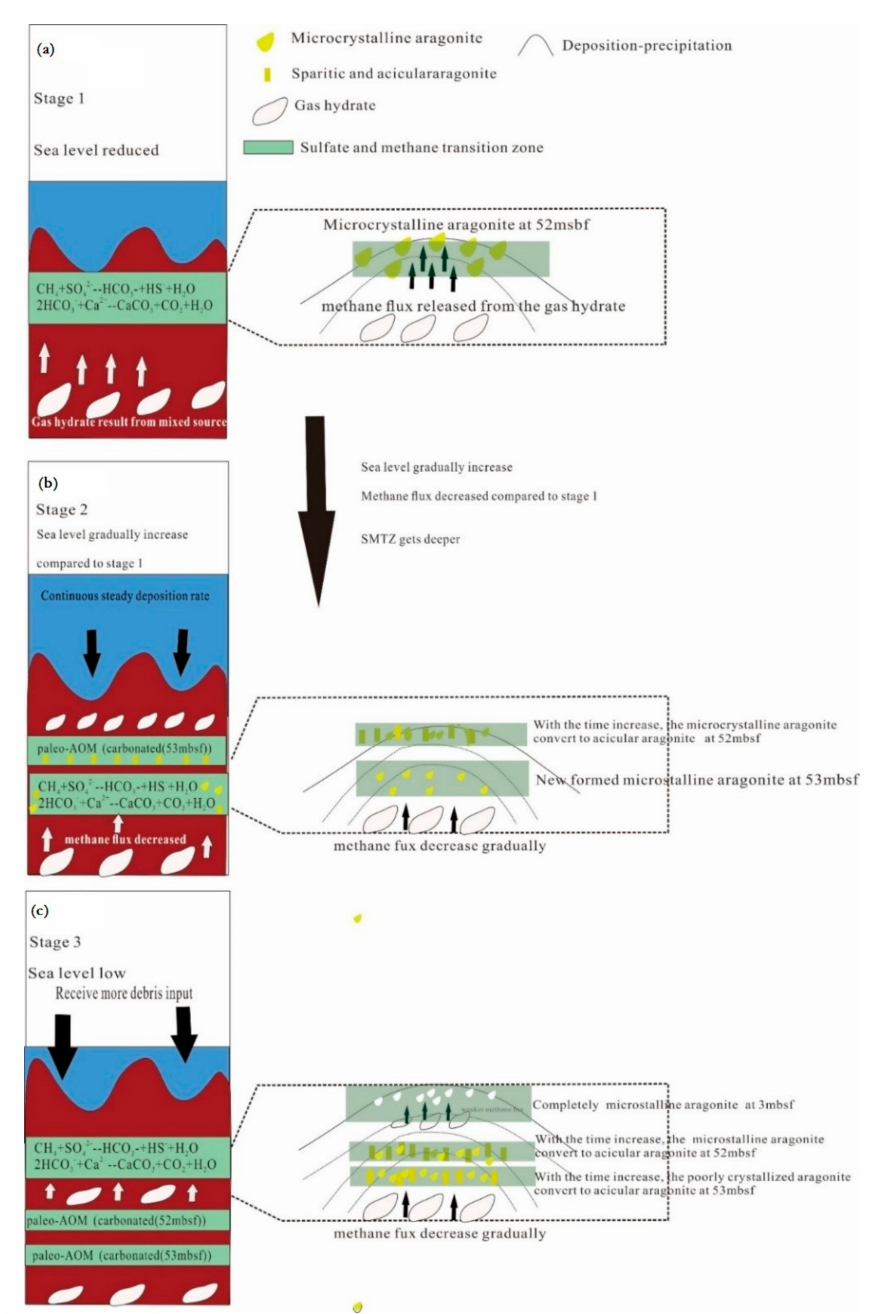
Figure 9. ( a ) Formation mechanism of carbonate at 52 mbsf: the sea level decreased dramatically. This caused a decrease in hydrostatic pressure. Under such a condition, gas hydrate became unstable and released methane into shallower sediments. When it reached the sediment–water interface, the released methane reacted with sulfate and carbonate precipitated as a by-product of AOM. ( b ) formation mechanism of carbonate at 53 mbsf: The methane flux gradually decreased with the gradually increasing sea level. Hence, the SMTZ oved down and was fixed at new balanced layers. At the same time, the carbonate at 53.6 mbsf formed at the bottom of carbonate at 51.2 mbsf and ( c ) formation mechanism of carbonate at 3 mbsf: At about 12 ka BP, the newly formed hydrate was influenced by the drop of the sea level and released methane into shallow sediments. With the help of AOM, carbonate at 3 mbsf